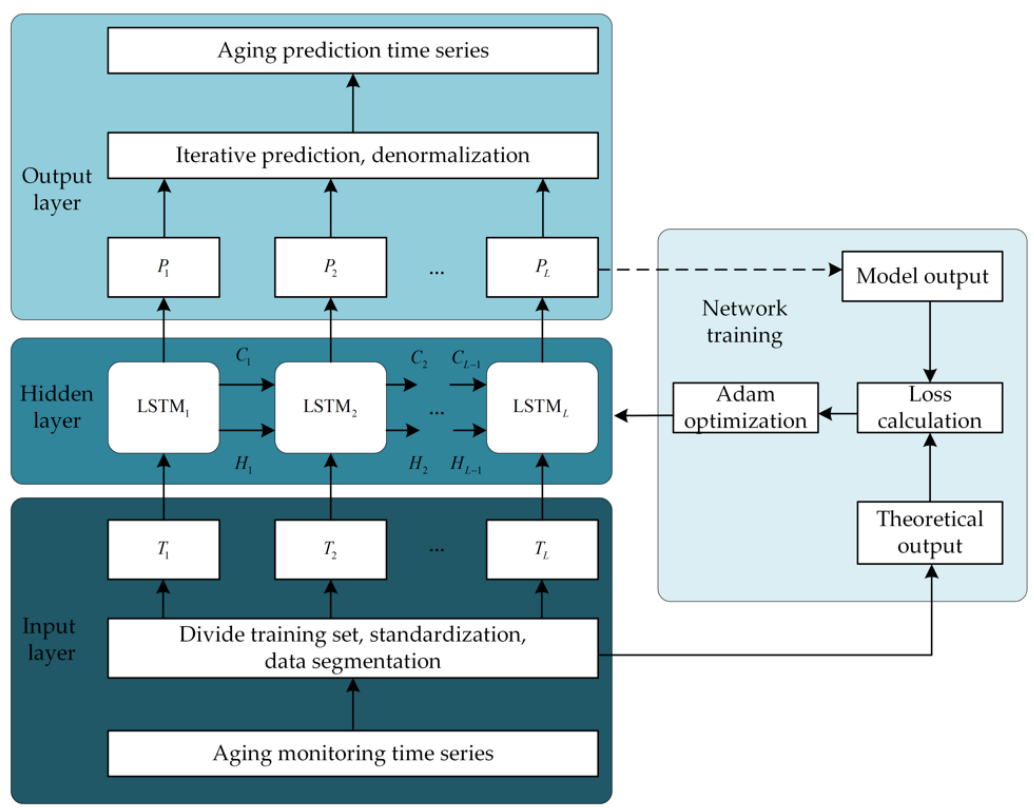
Electronics 2020 , 9 , x FOR PEER REVIEW Figure 3. Aging time series prediction framework based on LSTM. Figure 3. Aging time series prediction framework based on LSTM.